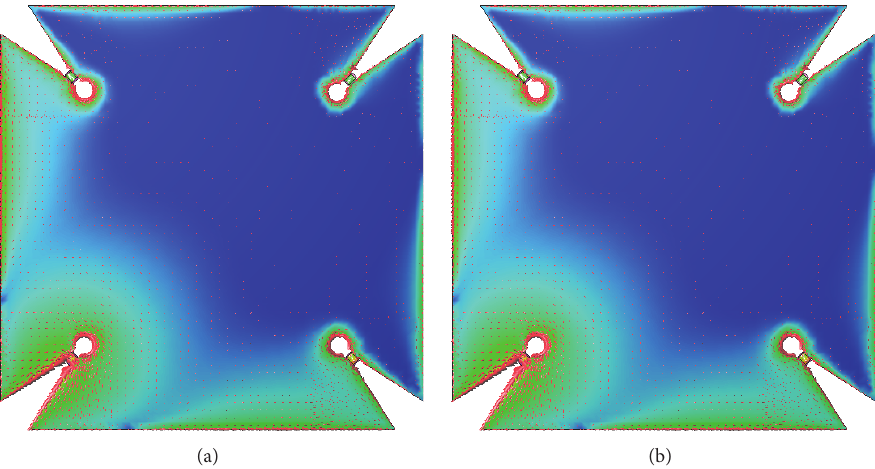
Figure 3: Surface current distributions of the scalable 4-port antenna system as Port 1 is activated at (a) 2.4 GHz for Ant. 1 design and (b) 5 GHz for Ant. 2 design.